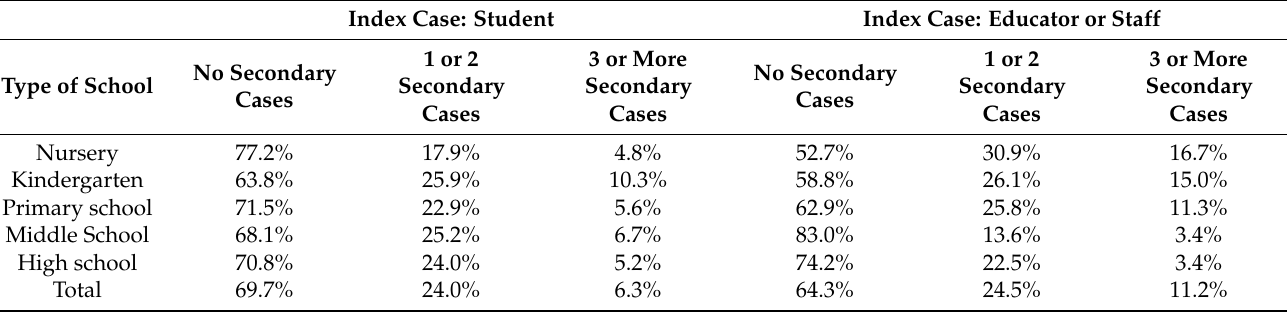
Table 3. Distribution of secondary cases by type of school and type of index case. The total number of infections is reported in Table S1 (Supplementary